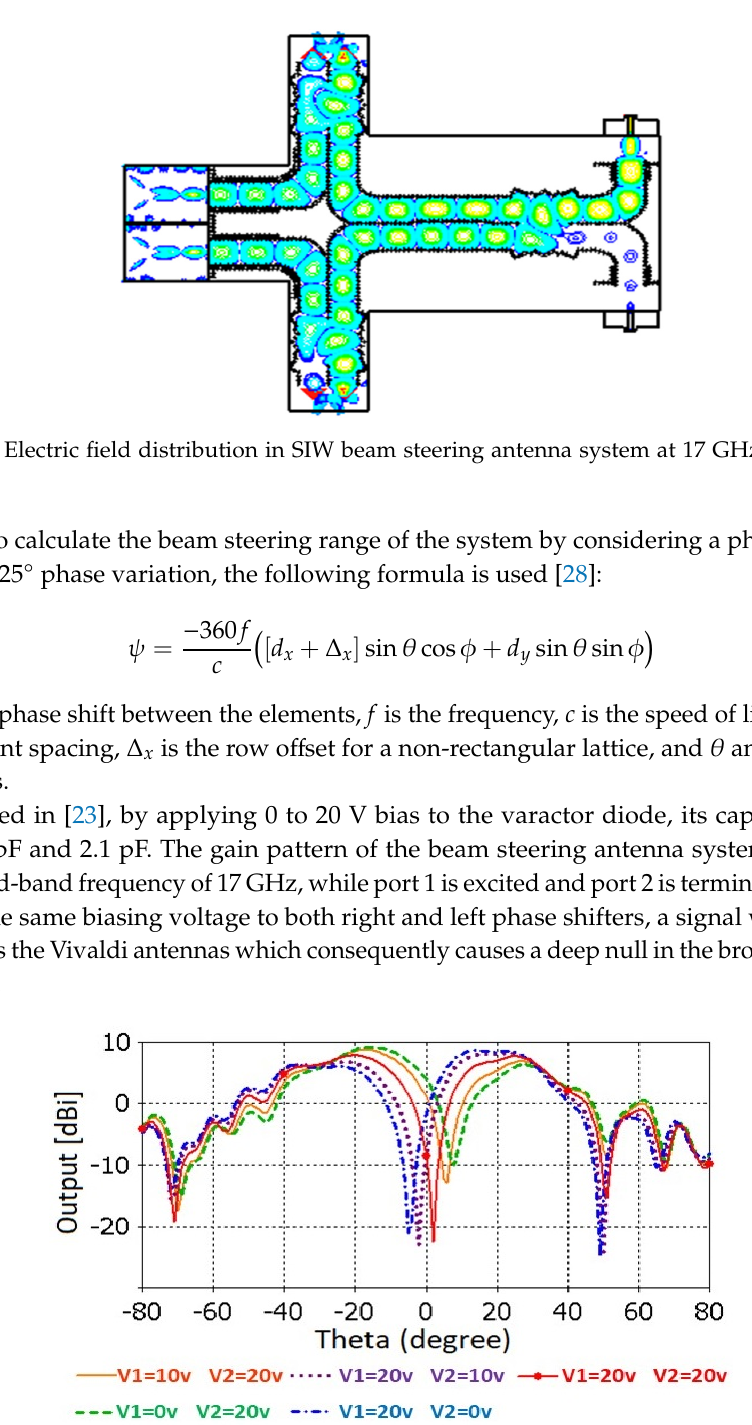
Figure 12. Simulated gain patterns of the beam steering antenna system at 17 GHz for 5 different loadings while port 1 is excited.